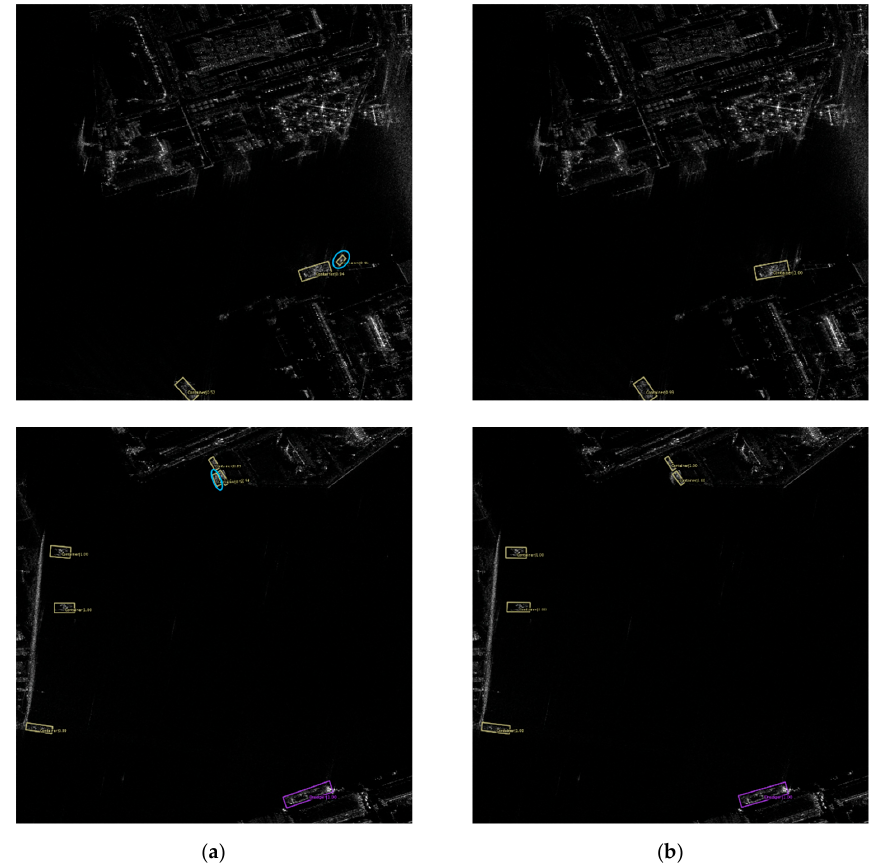
Figure 6. Comparison detection results of the Oriented-RCNN and our method. The yellow ellipses and blue ellipses represent the missing ships and false alarms, respectively. ( a ) Detection results of Oriented-RCNN. ( b ) Detection results of SPG-OSD.